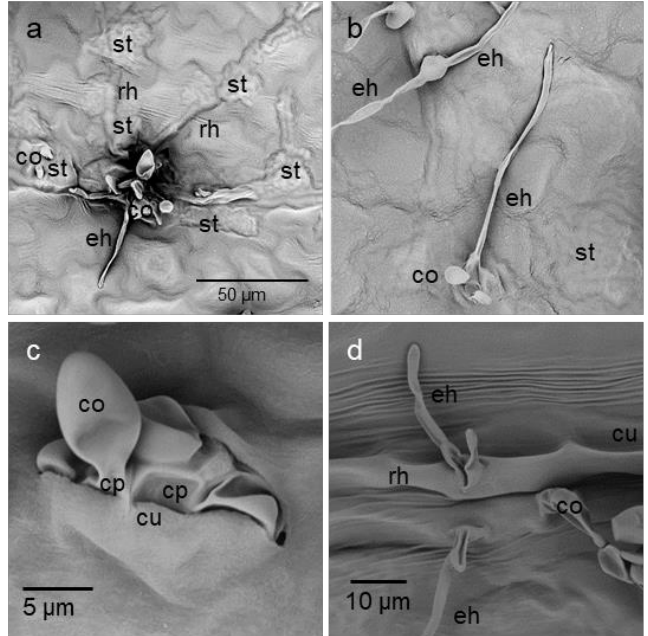
Figure 6. Pathogen structures on chlorotic tissue of an apple leaf 19 dpi with Venturia inaequalis isolate SW01. Rare and low formation of conidia (co) despite of strong sub-cuticular formation of runner hyphae (rh) and secondary stroma (st) with lobated hyphae ( a ); formation of lateral epicuticular hyphae (eh) from conidiophores ( b ); penetration of the cuticle by conidiophores with young conidia ( c ); formation of epicuticular hyphae directly from sub-cuticular runner hyphae, formation of a conidium from neighbouring stroma ( d ). Scanning electron microscopic images.